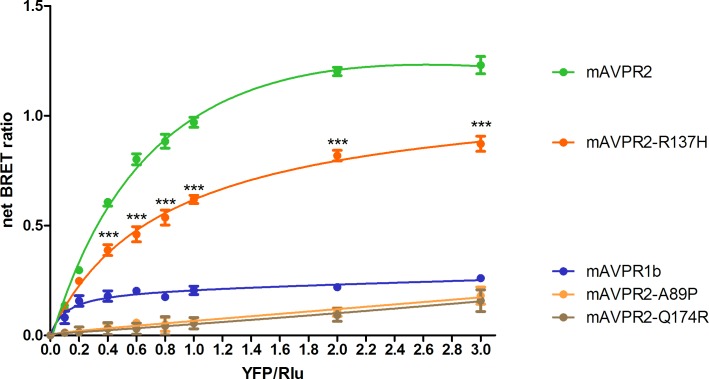
Oligo-complex formation rescues the constitutively endocytosed mAVPR2 mutant R137H.The constitutively β-arrestin bound R137H mutant of mAVPR2 is largely endocytosed. With co-expression of mSCTR, however, an increase in net BRET signal suggests rescue of the R137H mutant to the cell surface by heterocomplex formation. The mutations of A89P or Q174R, which lead to improper folded, non-surface reaching receptors, cannot be rescued by the formation of heteromer. Significance level was calculated against the mAVPR1b control. The data were mean±SEM from three to five independent experiments in triplicate. ***, P<0.001.